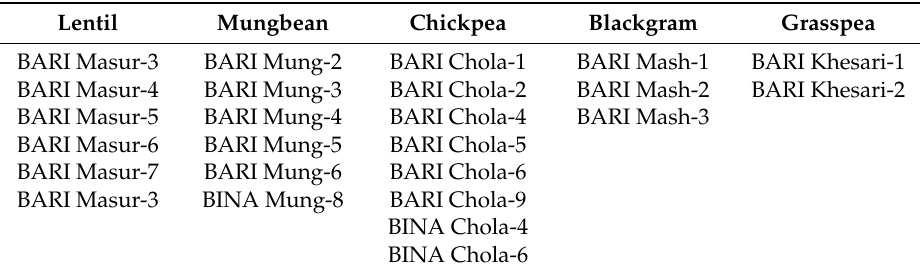
Table A1. Name of the improved varieties of pulses grown by the farmers.